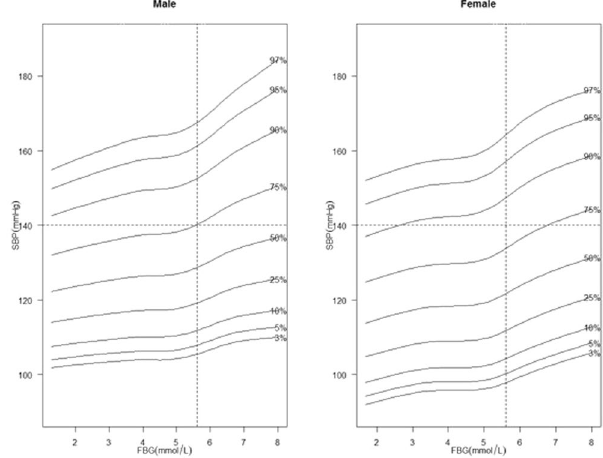
Figure 2. Smoothed SBP percentile curves for males and females.